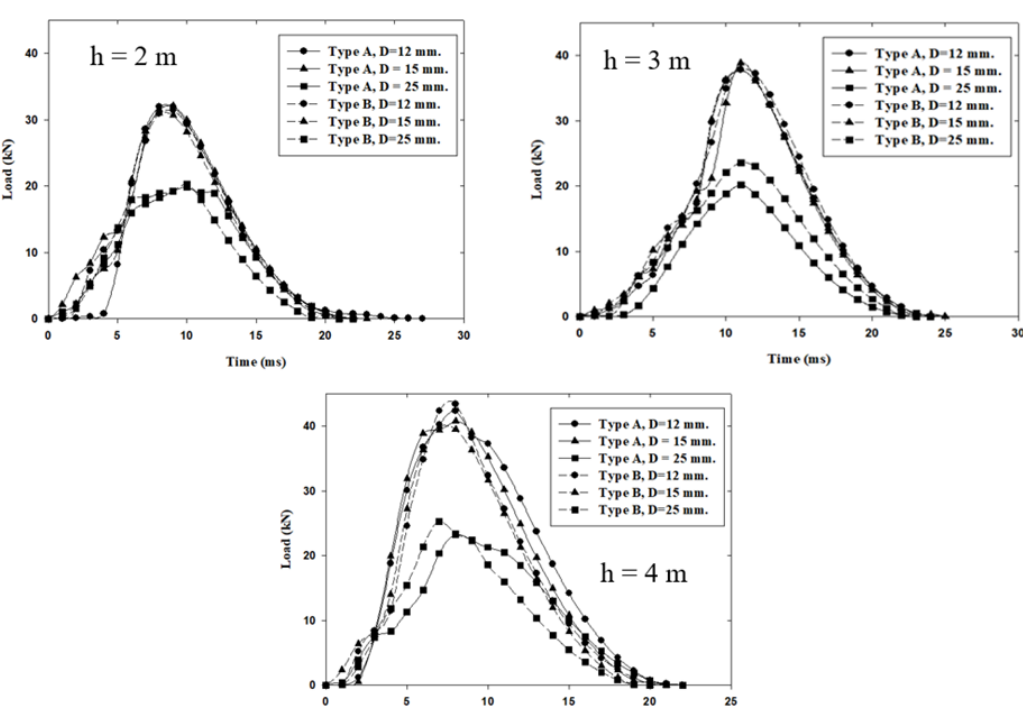
Figure 5: The impact load of Type A and Type